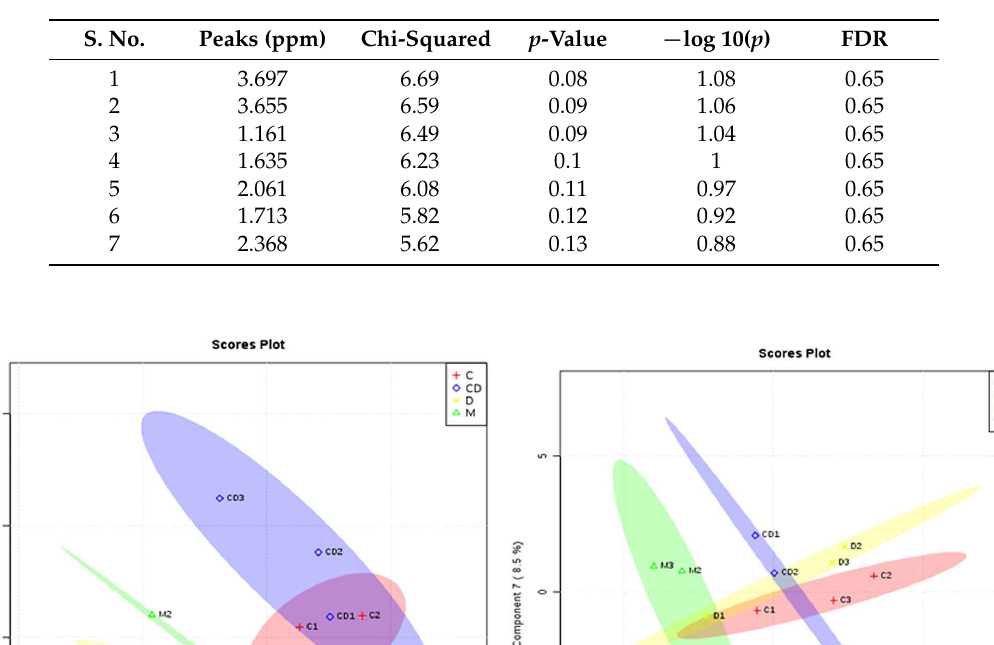
Table 1. Important features identified by one-way ANOVA and post-hoc analysis.